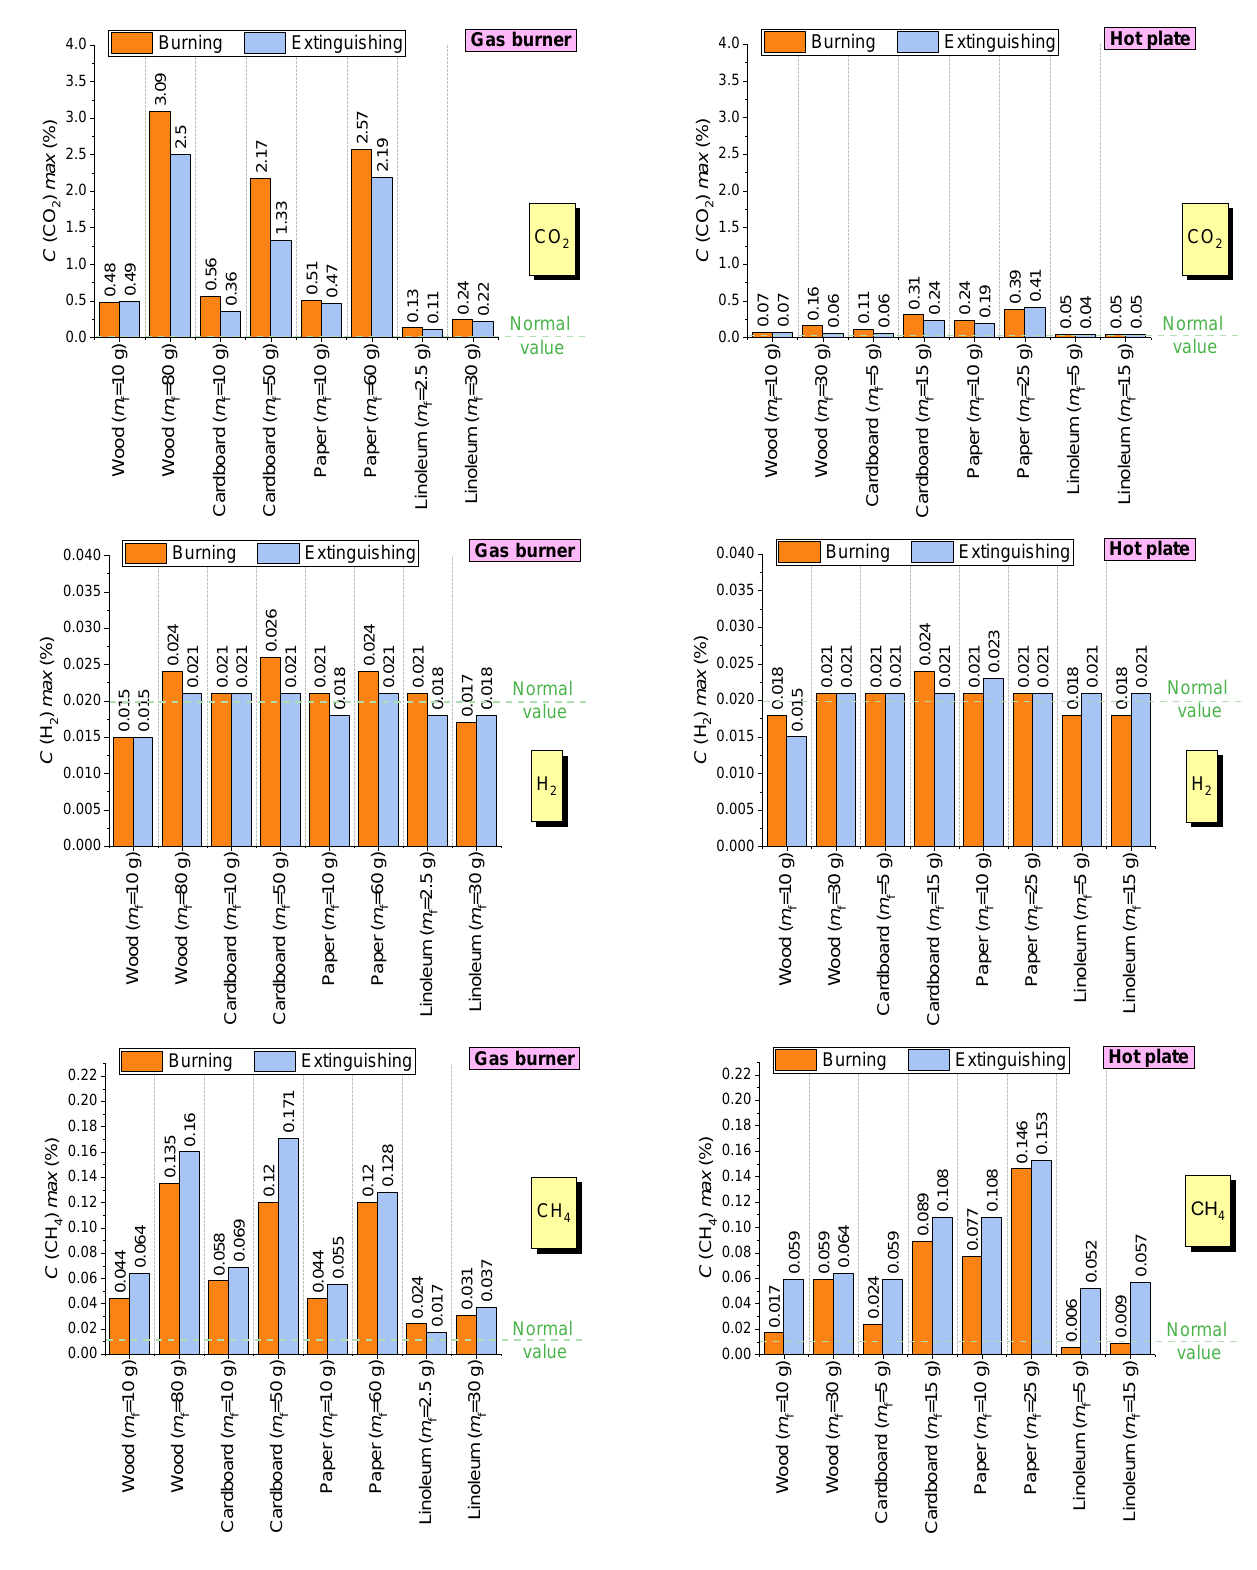
Figure 15. Cumulative histograms of threshold concentrations of gas components (O 2 , CO, CO 2 , H 2 and CH 4 ) recorded for all the model fires under study when reproducing the conditions of careless handling of fire (gas burner) and improper use of heating equipment (hot plate) (Burning – experimental results for the thermal decomposition of the model fire without suppression; Extinguishing – experimental results for extinguishing the model fire during thermal decomposition).